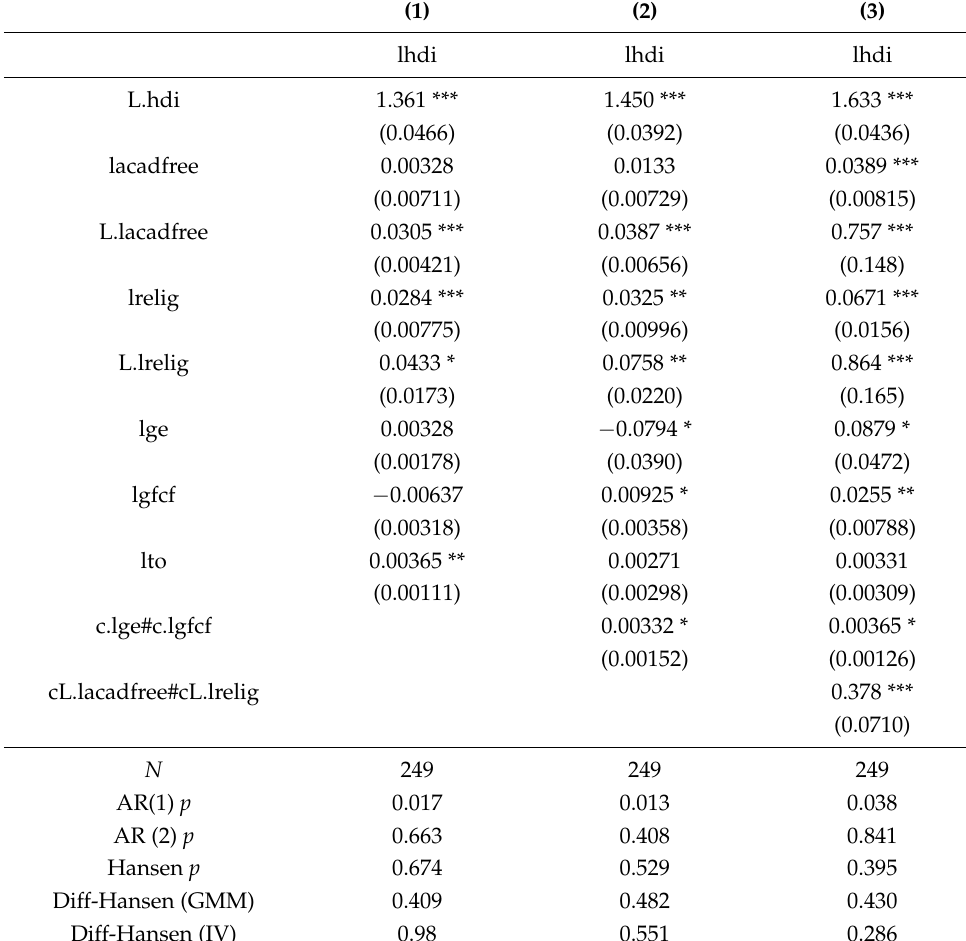
Table 2. System GMM